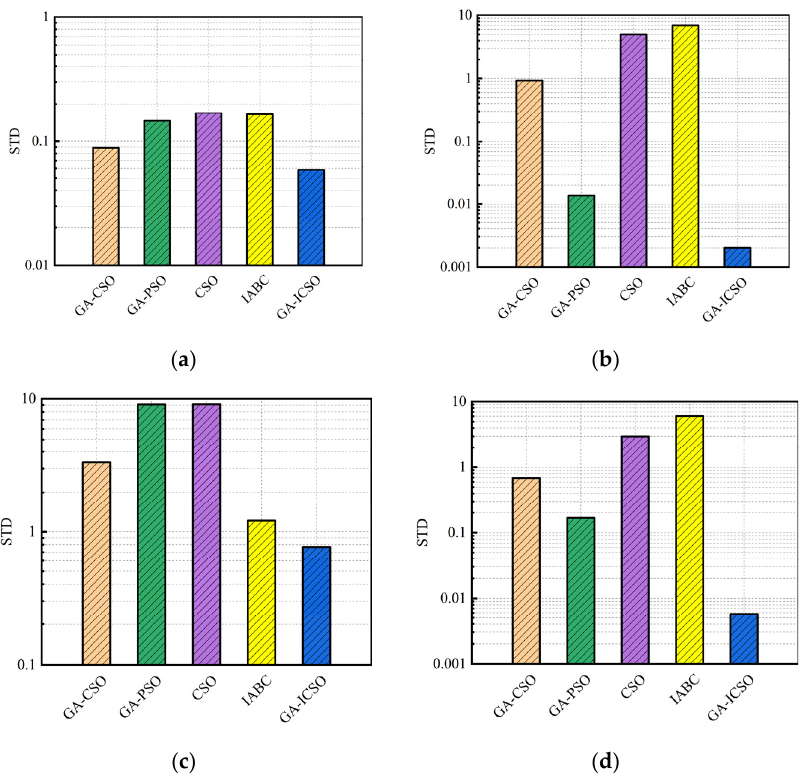
Figure 12. STD for 4 test functions: ( a ) Griewank; ( b ) Zakharovfcn; ( c ) Ackley; ( d ) Schwefel 2.21.